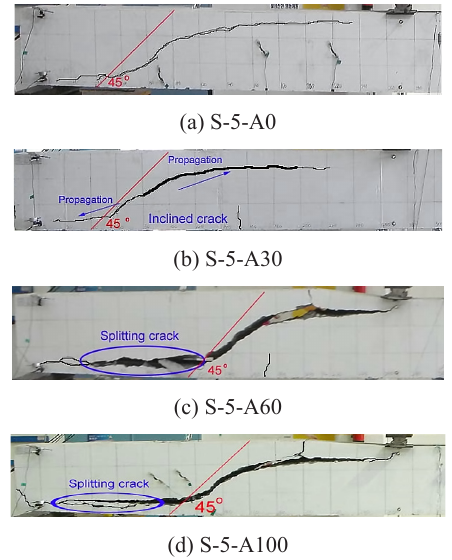
Fig. 5. Crack patterns with respect to replacement rate with recycled aggregate